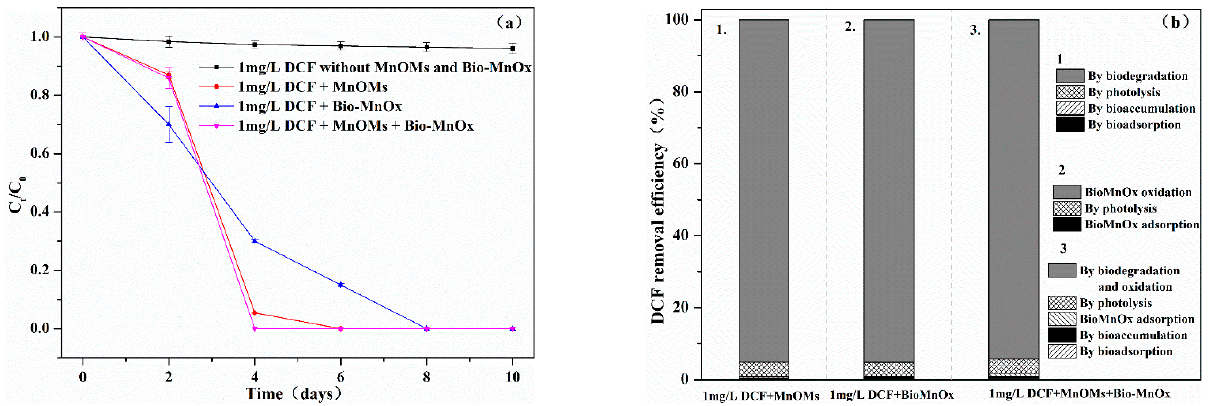
Figure 4. DCF removal efficiency by MnOMs, Bio-MnOx, and a combination of MnOMs and Bio- MnOx; ( a ) variation of the DCF concentration over time; ( b ) DCF removal efficiency by different processes after 10 days.